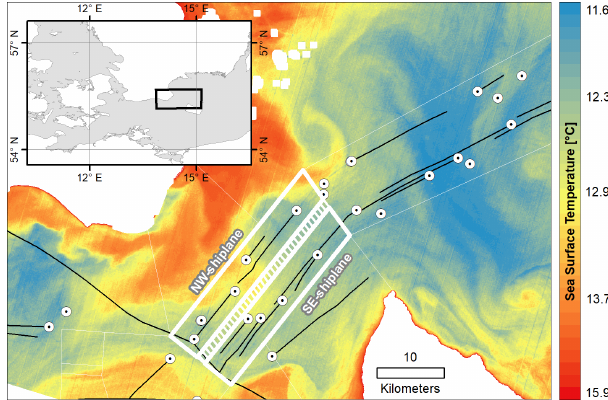
Figure 12. Ships and visible thermal wakes in the Bornholm sound from the analysed satellite scene from 25 May 2014 10:01LT. White circles with black dots indicate ships with an AIS transmit- ter present in the area at the time of the satellite passage, and the black lines are the digitalised visible thermal wakes from the satel- lite scene. White lines indicate the shipping lane area, the bold lines mark the north-west and south-east shipping lanes, and the hatched area is the traffic separation zone. Landsat-8 image courtesy of the US Geological